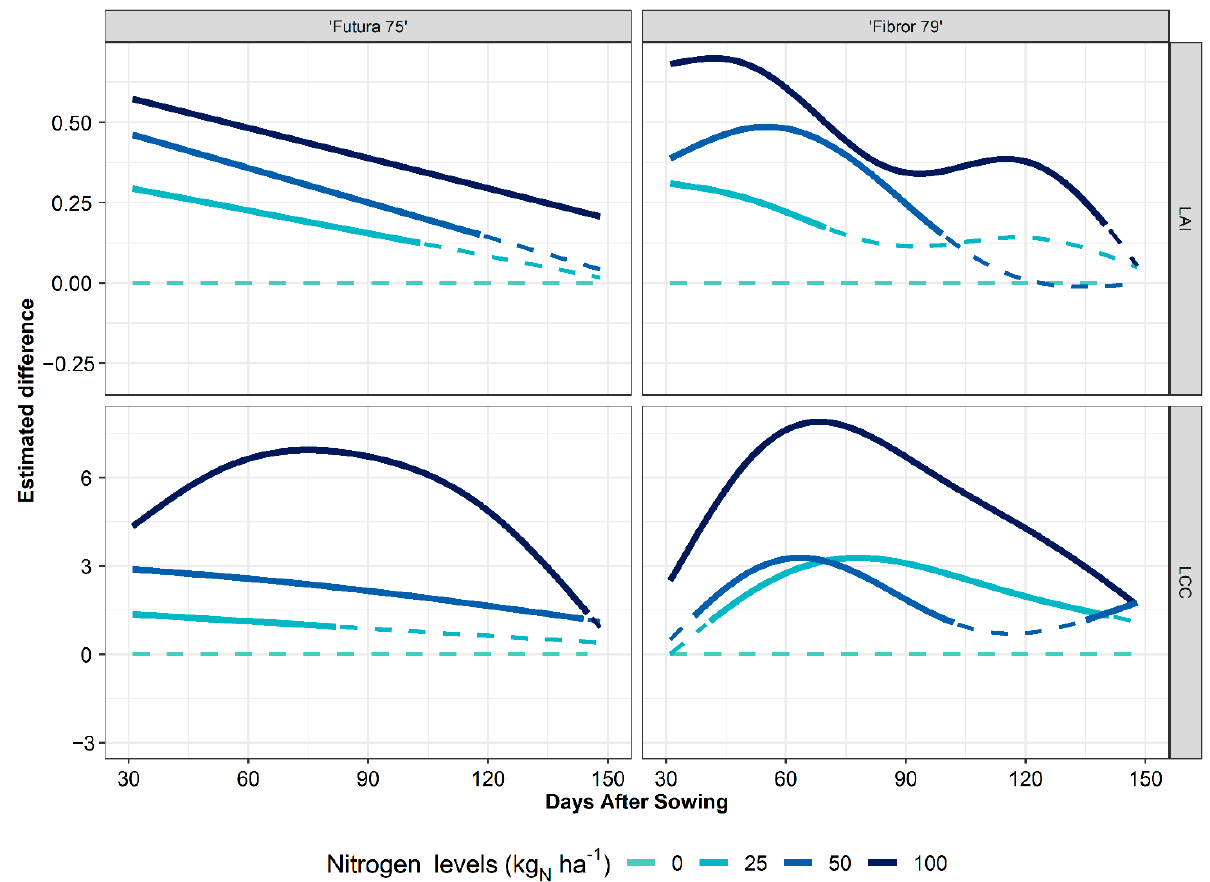
Figure 12. Dynamics of the estimated difference of LAI and LCC across nitrogen fertilisation levels for hemp cultivars. The reference nitrogen fertilisation level with 0 kg N ha − 1 is represented with a light green dashed line. The estimation of the differences between nitrogen fertilisation levels along the time series was carried out using a GAM. Solid and dashed coloured lines denote, respectively, significant ( p -value < 0.05) and not significant differences of the corresponding nitrogen fertilisation levels compared to the reference nitrogen fertilisation level (0 kg N ha − 1 ). A positive difference between the reference and any other level of nitrogen fertilisation means that the reference has a lower value of LAI and LCC.